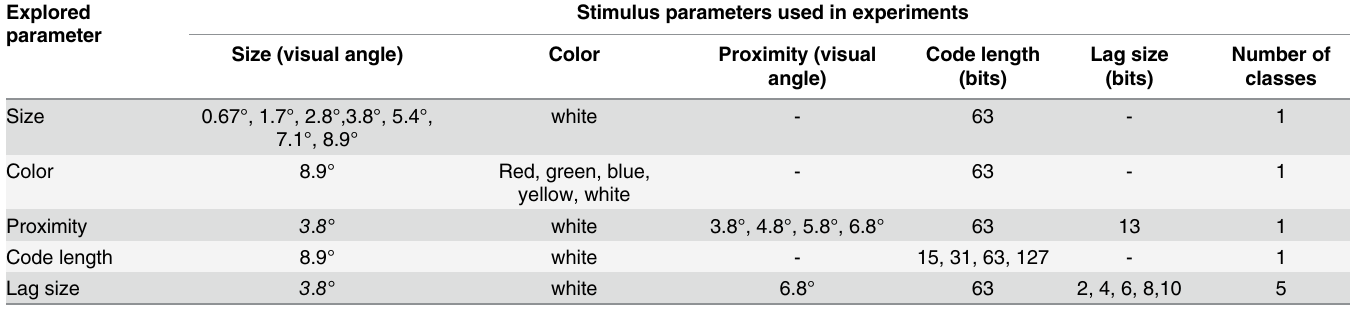
Stimulus parameters used in